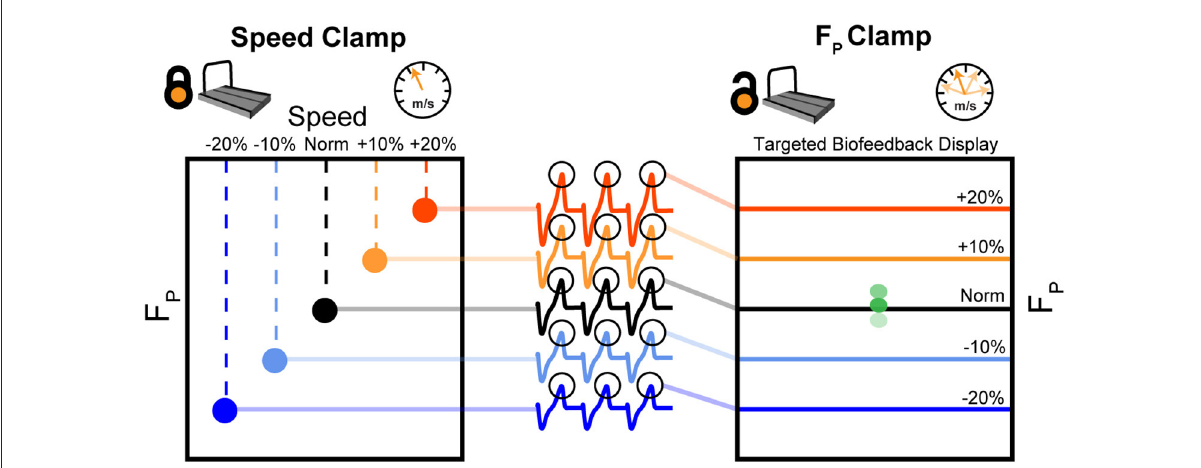
FIGURE2 First, participants walked at their typical, overground walking speed (Norm) as well as ± 10 and ± 20% of Norm. During these 5-min, fixed-speed trials (speed clamp), we measured and averaged F P from each step over the duration of the trial. During another set of five 5-min trials, we used targeted biofeedback and the self-paced treadmill mode to prescribe F P by asking participants to target each of their average F P values from the speed clamp while allowing participants to naturally adjust their walking speed (F P